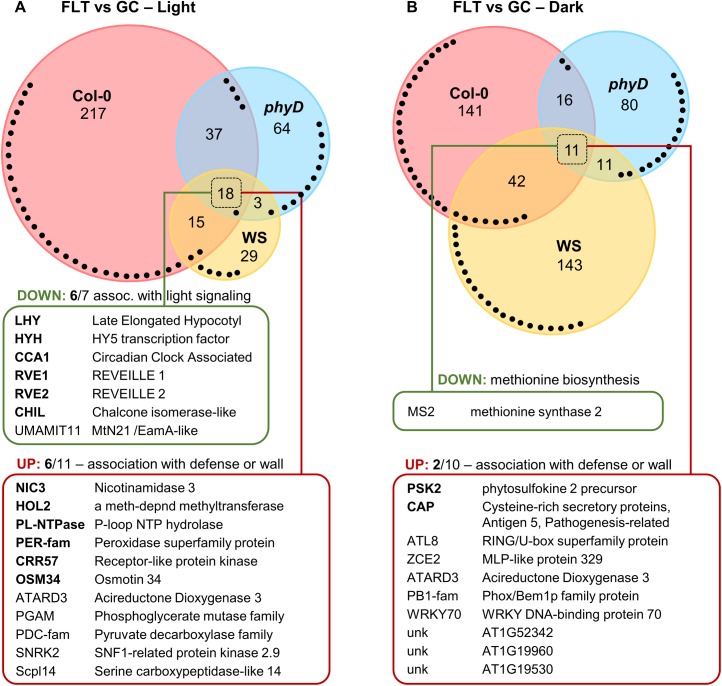
A Venn diagram displaying the distribution of coordinately expressed genes in response to spaceflight in all three genotypes.(A) Coordinately expressed genes in the root tips of light-grown plants. (B) Coordinately expressed genes in the root tips of dark-grown plants. Coordinately expressed genes common to all three genotypes are annotated below each diagram. The number of differentially expressed genes associated with cell wall processes are indicated as black dots within each representative sector of the diagram. The small number (11 in the light and 17 in the dark) of significantly expressed genes that are represented in two genotypes, but were changed in opposite directions (up in one genotype while down in the other), are not included in the enumerations of coordinately expressed genes in the Venn diagrams.